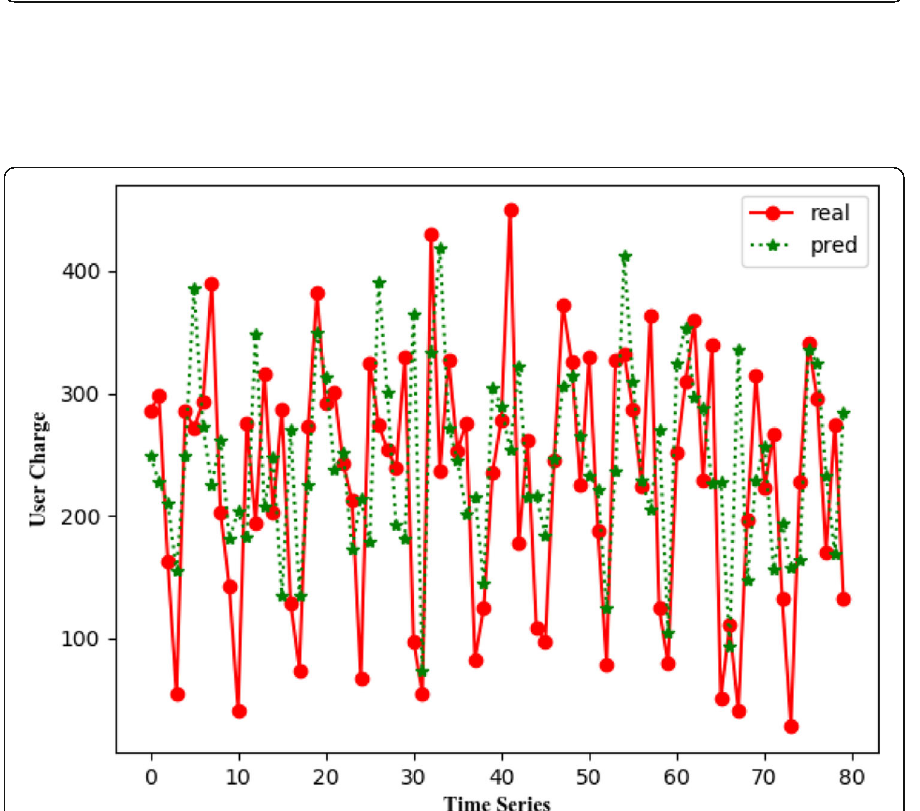
Fig. 7 Regular charging data prediction results. This figure demonstrates the prediction results of irregular charging data and regular charging data,